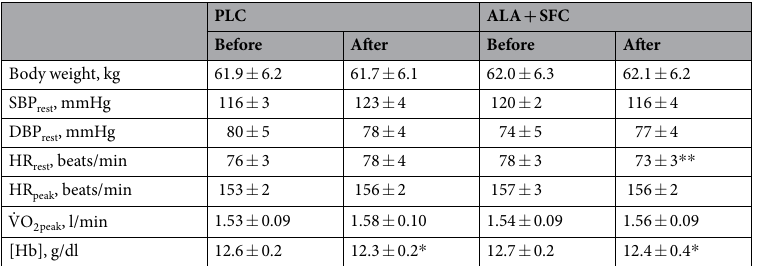
Table 2. Physical characteristics of subjects. Values are the means ± SE for 9 subjects in each trial. PLC, placebo intake condition; ALA + SFC, 5-aminolevulinic acid + sodium ferrous citrate intake condition; SBP rest and DBP rest , resting systolic and diastolic blood pressure, respectively; HR rest , resting heart rate; HR peak , peak heart rate at  V O 2 peak ;  V O 2 peak , peak oxygen consumption rate during the graded cycling test; [Hb], haemoglobin concentration in blood. * , ** Compared with before supplement intake, P < 0.05 and P < 0.01,